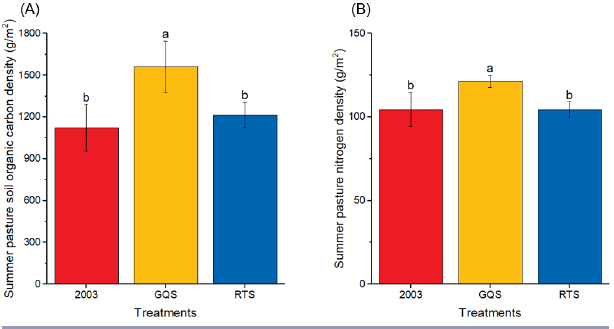
Fig. 3 . The aboveground biomass of summer pasture at baseline in 2003 and under the community quota system (GQS) and rangeland transfer system (RTS) in 2014. Note: there was a significant difference among 2003, GQS, and RTS at the level of 0.05.